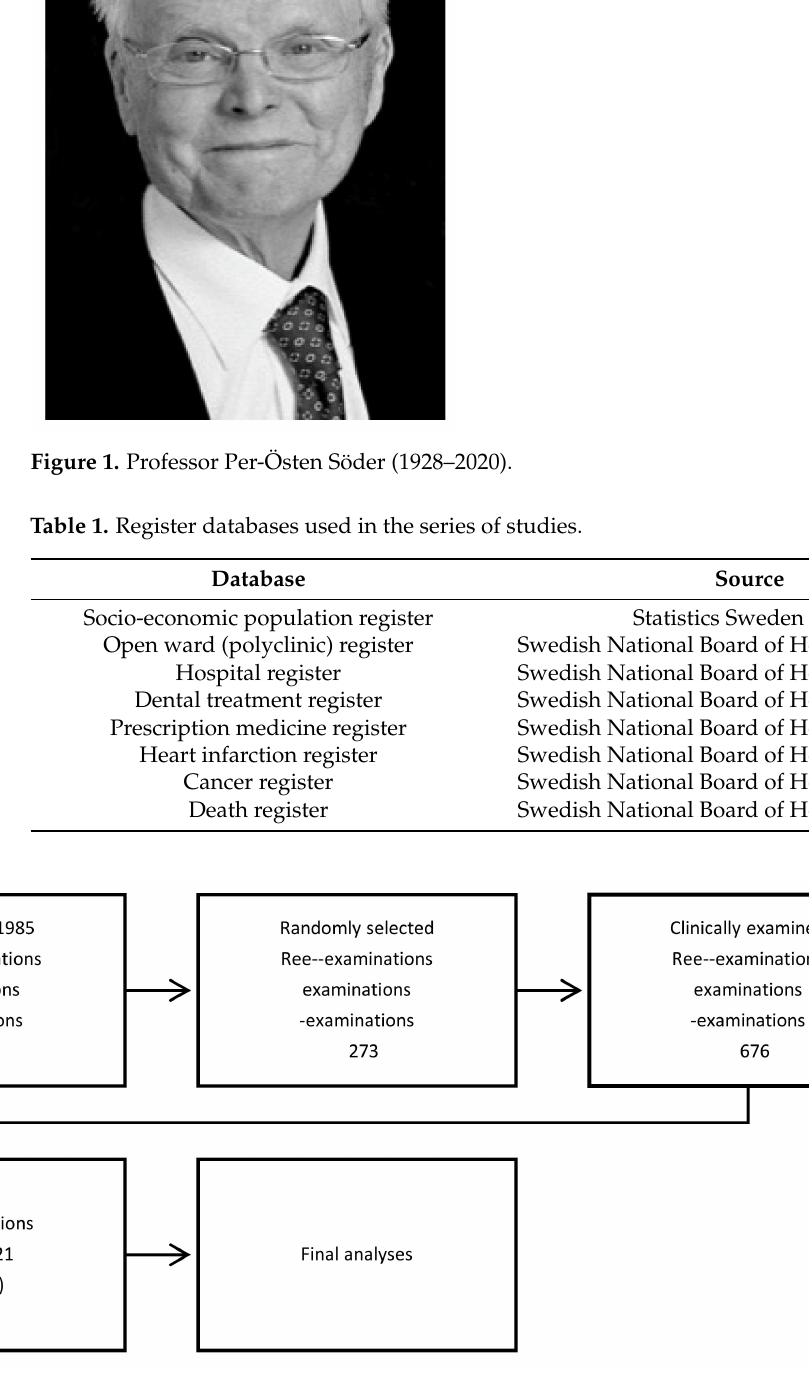
Figure 2. Profile of The Stockholm Study. At the re-examinations, the number of patients selected by computer program vary from